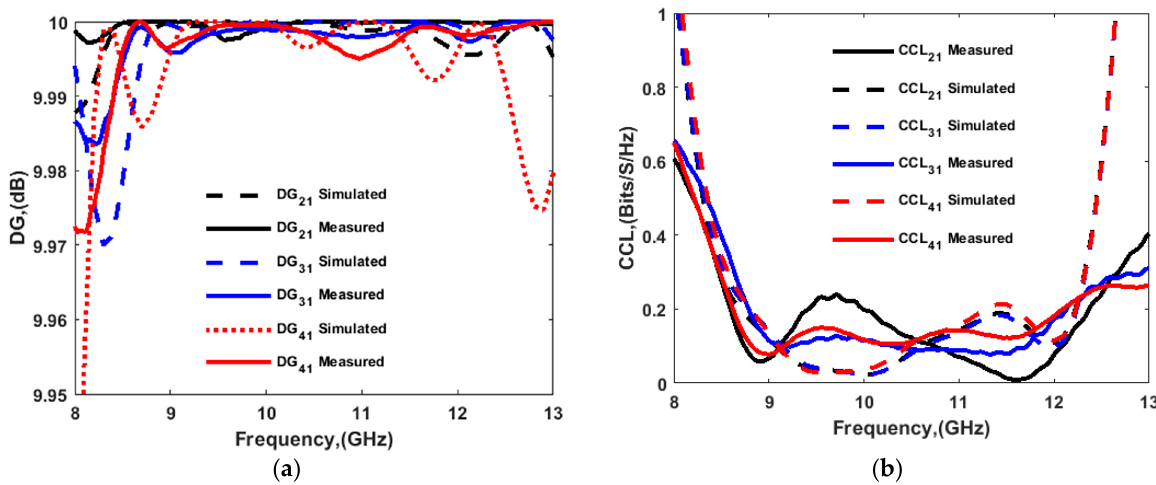
Figure 19. ( a ) Diversity gain (DG) and ( b ) channel capacity loss (CCL).